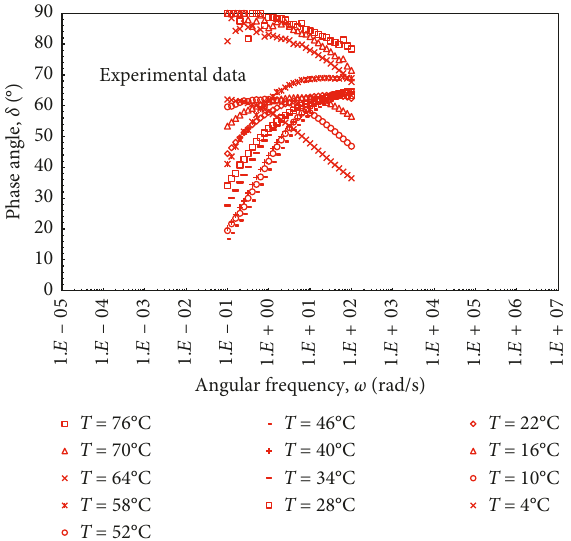
Figure 17: Experimental results of phase angle ( δ vs. ω )—CSR.